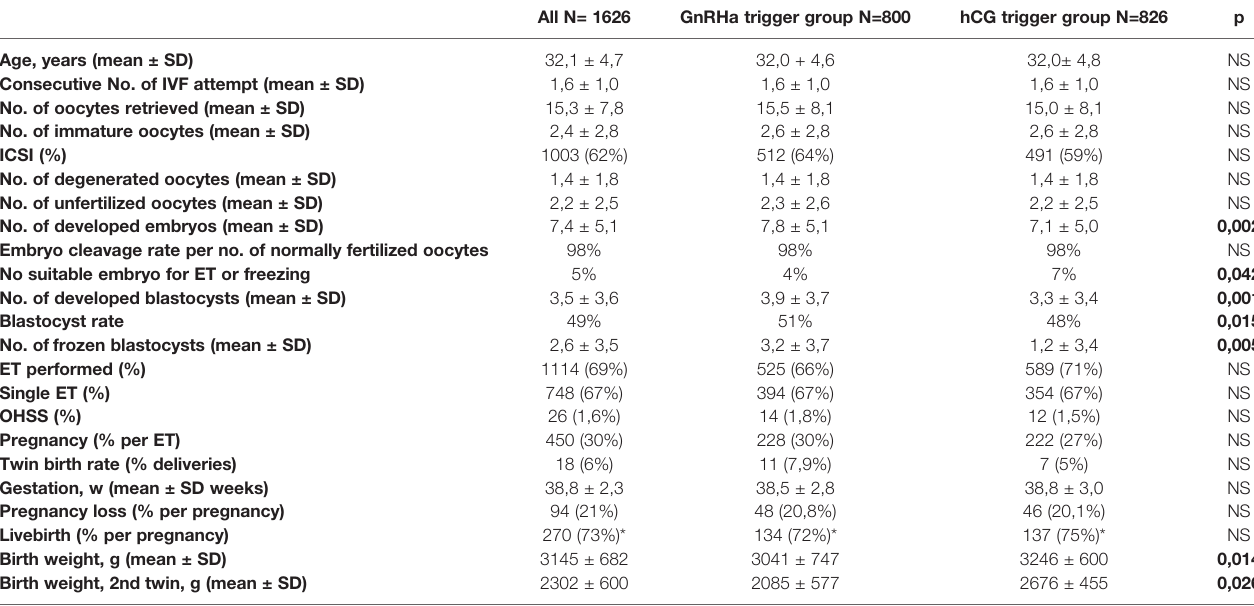
TABLE 2 | Comparison of IVF-ICSI outcome for women in the GnRHa versus hCG trigger group after matching by age and number of oocytes. All N=